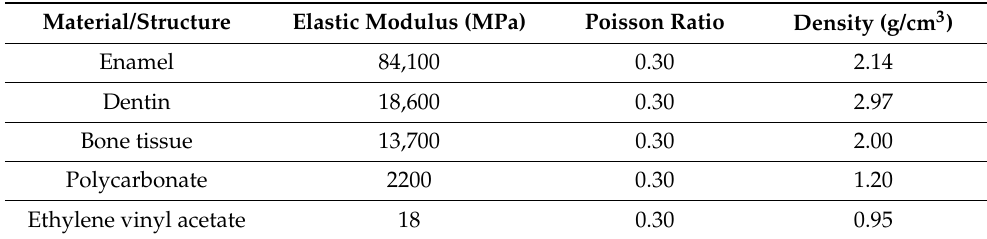
Table 1. Mechanical properties considered in the finite element